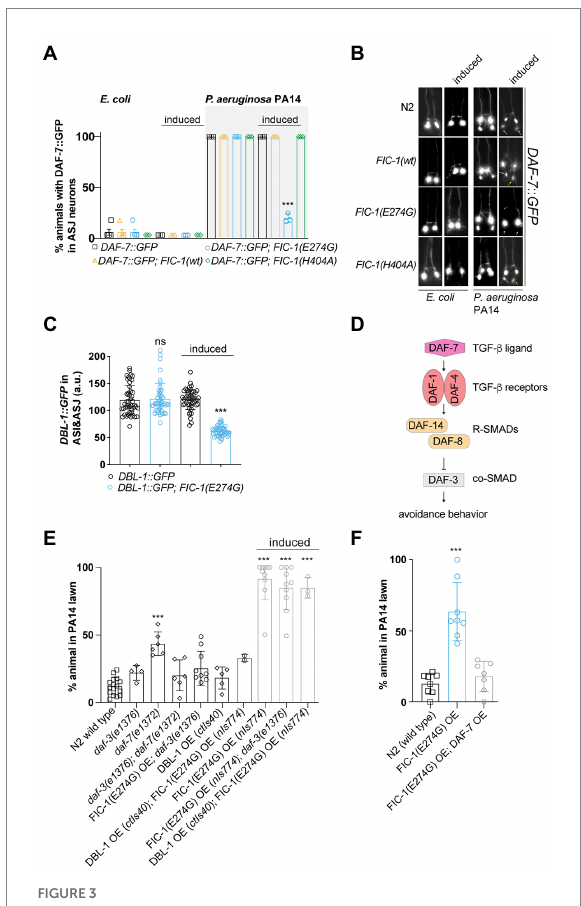
FIGURE 3 FIC-1(E274G)::HA OE suppresses TGF- β signaling in ASJ neurons in response to P. aeruginosa PA14 exposure. (A,B) Induced and non-induced strains were placed on E. coli OP50 or P. aeuruginosa PA14 lawns and incubated for 15 h, after which we determined the number of GFP-expressing in ASJ